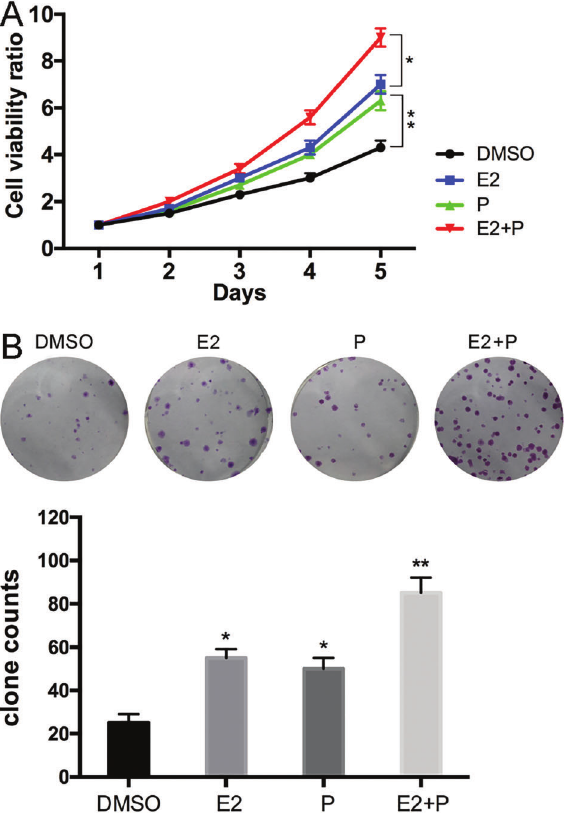
Figure 2. Combination of estradiol (E2, 10 -10 M) and progester- one (P, 10 -8 M) in cell proliferation effects. A , Cell viability in each group was monitored over fi ve continuous days. B , Colony formation ability in each group of cells stained with crystal violet (upper panel) and counted (lower panel). Data are reported as means ± SD. *P o 0.05; **P o 0.01 vs DMSO group (control) (Student ’ s t -test).